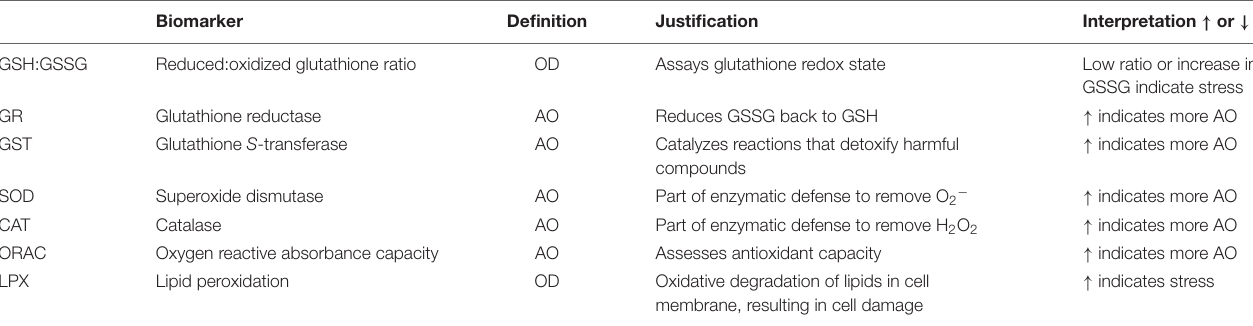
TABLE 1 | Definition, justification, and interpretation of used biomarkers with zooplankton examples from literature. Biomarker Definition Justification Interpretation ↑ or